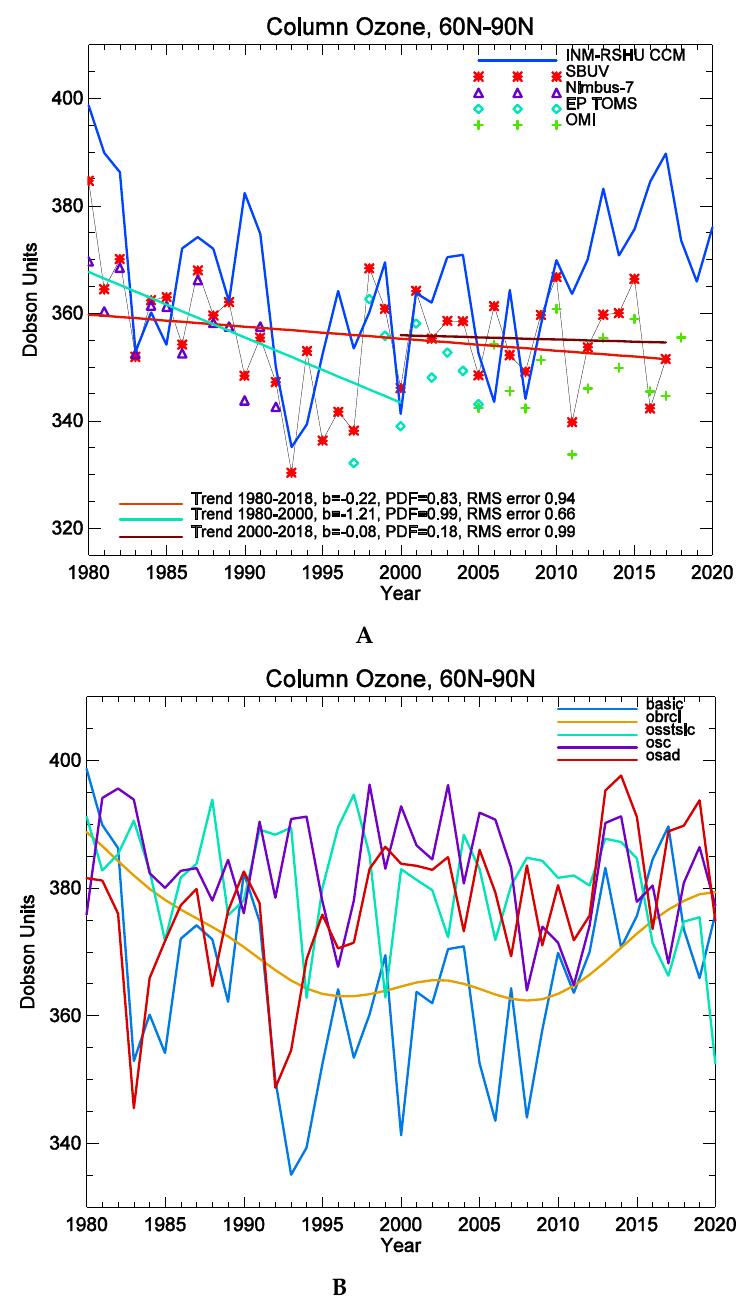
Figure 5. Interannual variability of column ozone in the northern polar latitudes: ( A ) Results of satellite measurements (solar backscattering ultraviolet (SBUV), Nimbus-7 Total Ozone Mapping Spectrometer (TOMS), Earth Probe (EP) TOMS, and the Ozone Monitoring Instrument (OMI)) and numerical modeling (chemistry–climate model of the Institute of Numerical Mathematics and the Russian State Hydrometeorological University) with an assessment of trends (b—coefficient of linear regression) and their significance (PDF—probability density function, and RMS—root mean square error); ( B ) results of numerical modeling under scenarios with a separate action of influencing factors: basic—all factors’ interannual variabilities are taken into account, obrcl—only the surface emissions of bromine and chlorine-containing gases’ interannual variability is taken into account, osstsic—only sea surface temperature and sea ice coverage interannual variabilities are taken into account, osc—only solar radiation’s interannual variability is taken into account, osad—only sulfate aerosol density’s interannual variability is taken into account.